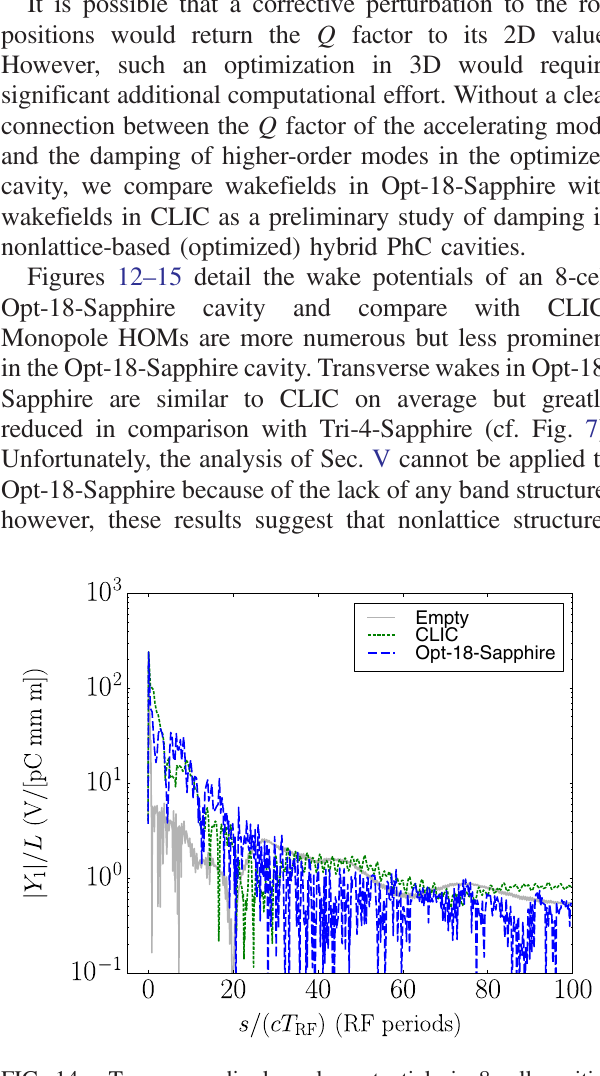
FIG. 15. Transverse dipole impedance in 8-cell cavities using conducting